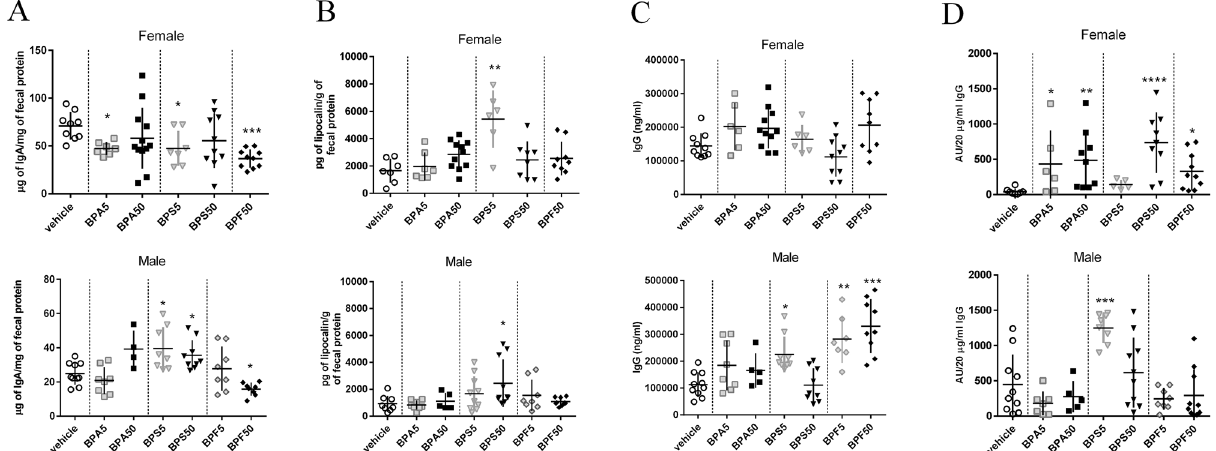
Figure 2. Impact of dermal exposure to bisphenols on intestinal IgA production, intestinal inflammation, total IgG and specific IgG responses against E. coli in adult offspring mice. ( A ) Total IgA concentration measured by ELISA in fecal samples of female and male offspring mice at PND70. ( B ) Lipocalin concentration determined in fecal supernatant of female and male offspring mice at PND70. ( C ) Plasma IgG concentration measured by ELISA. ( D ) IgG specificity against E. coli assessed by ELISA after normalizing to IgG concentrations. *P < 0.05; **P < 0.01; ***P < 0.001 vs. vehicle group. N = 5–12 offspring mice per